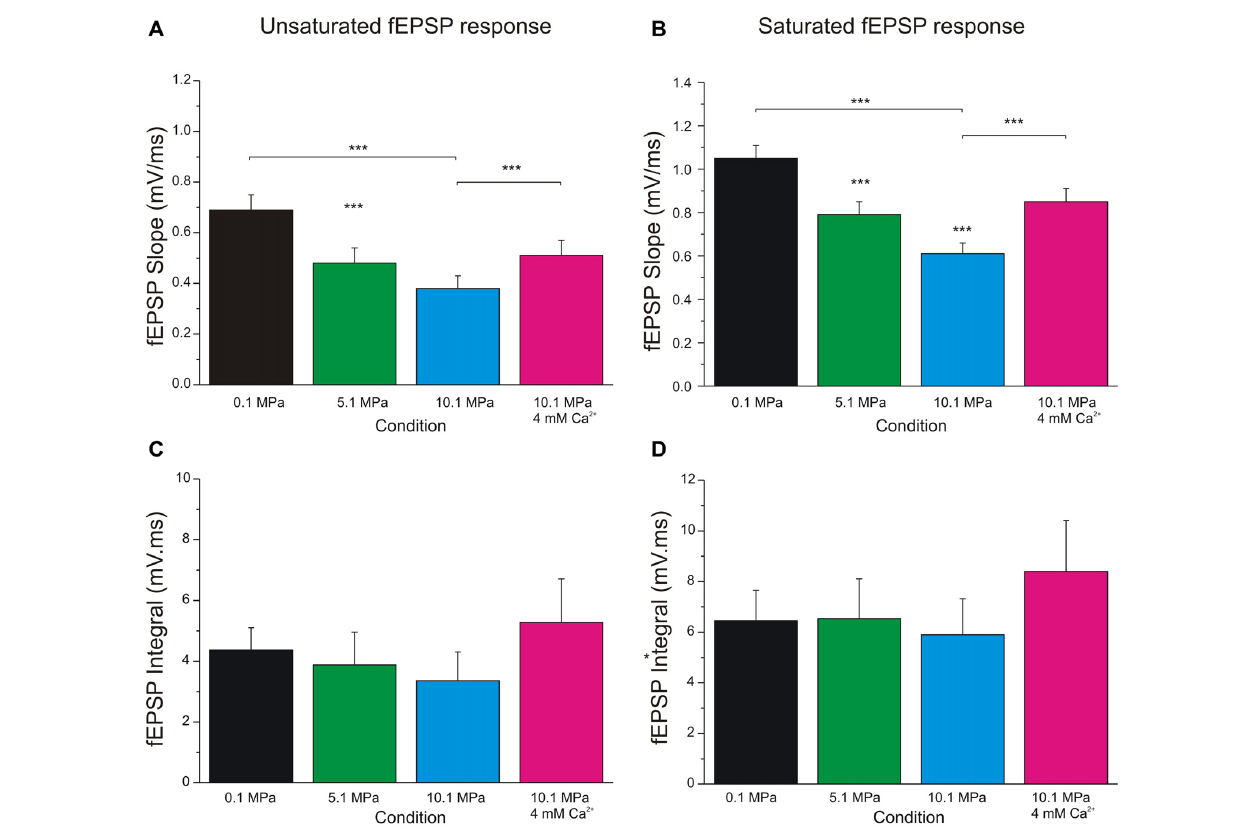
FIGURE 3 | Increasing extracellular calcium alleviates high pressure depression of MPP fEPSPs. High pressure effect and the antagonistic effect of increasing [Ca 2 + ] o from 2 to 4 mM on MPP fEPSPs. (A) Quantification of pressure and [Ca 2 + ] o effects on unsaturated fEPSPs’ slopes ( n = 24 for each condition). (B) Effect of pressure and [Ca 2 + ] o on saturated fEPSPs’ slopes ( n = 25 for each condition). (C) Quantification of pressure and [Ca 2 + ] o effect on unsaturated fEPSPs’ integral ( n = 5 for each condition; not statistically different). (D) Effect of pressure and [Ca 2 + ] o on saturated fEPSPs’ integral ( n = 5 for each condition; not statistically different). Data expressed in mean ± SEM. Significance level, if not otherwise specified, expresses difference with respect to the bar on the left ( ∗∗∗ p <